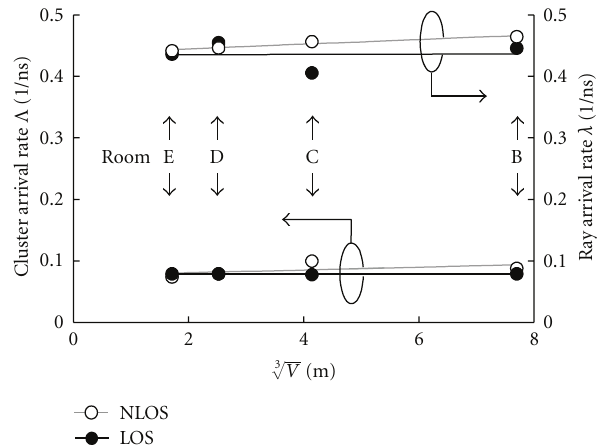
Figure 8: Arrival rates of clusters and rays within clusters.